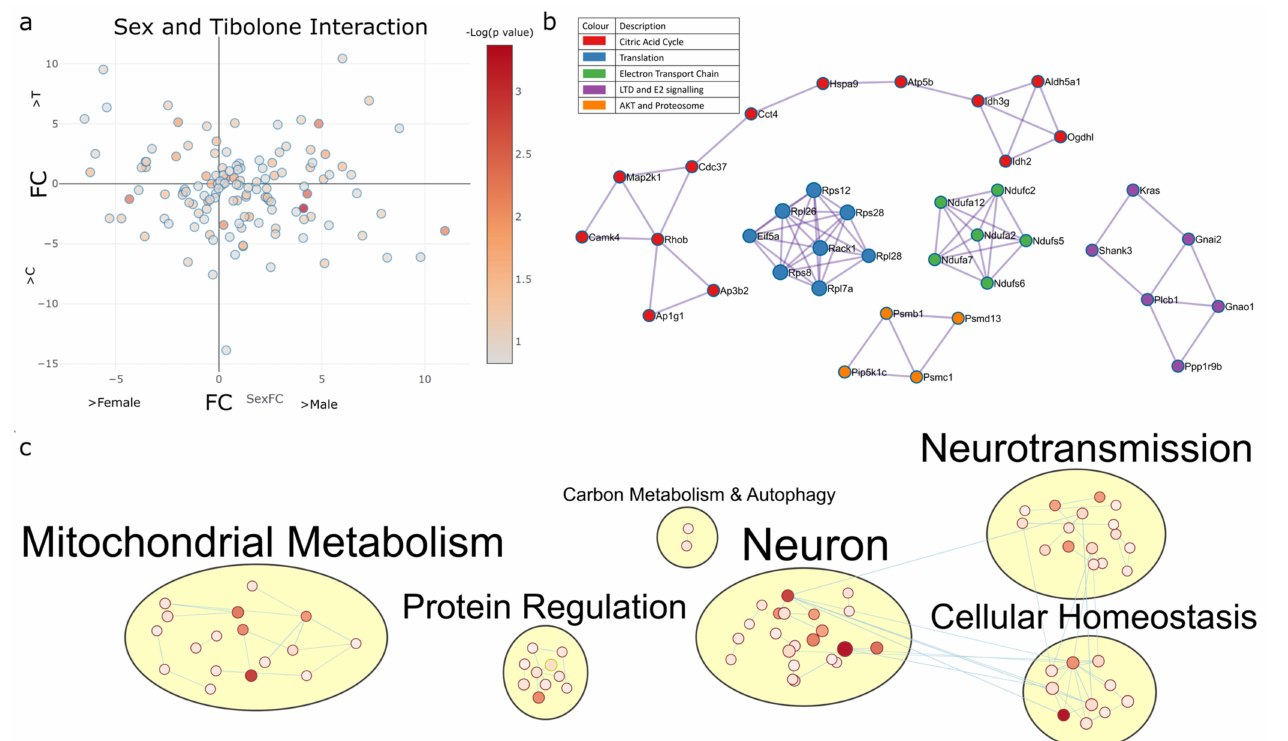
Figure 5. Functional enrichment predicts complex 1 protein regulation to have sex-specific responses to Tibolone. ( a ) A total of 132 proteins were found to be regulated by sex–Tibolone interactions. ( b ) PPI analysis of proteins regulated by sex–Tibolone interactions identified respiratory chain complex I, mitochondria (green, p = 2.5 × 10 − 17 ), cytoplasmic ribosomal proteins (blue, p = 2.5 × 10 − 13 ), long- term depression (purple, p = 1 × 10 − 9 ), PIP3 activation of AKT signalling (orange, p = 1.26 × 10 − 8 ) and the citrate cycle (TCA, krebs cycle) (red, p = 3.98 × 10 − 7 ) to be the most enriched functions in each cluster. Fully connected PPI analysis found Parkinson’s disease ( p = 3.98 × 10 − 10 ) to be the most significantly enriched function regulated by sex–Tibolone interactions. ( c ) When enriched functions were mapped, carbon metabolism- and autophagy-associated functions were identified to be uniquely regulated by sex–Tibolone interactions. The GO cellular component cytoplasm ( q = 1.22 × 10 − 23 ), KEGG pathway Alzheimer’s disease ( q = 5.17 × 10 − 10 ), reactome pathway metabolism (q = 1.23 × 10 − 8 ), GO molecular function identical protein binding ( q = 1.01 × 10 − 7 ) and GO biological process regulation of biological quality ( q = 5.23 × 10 − 7 ) were the functions most enriched by sex–Tibolone interactions in each enrichment